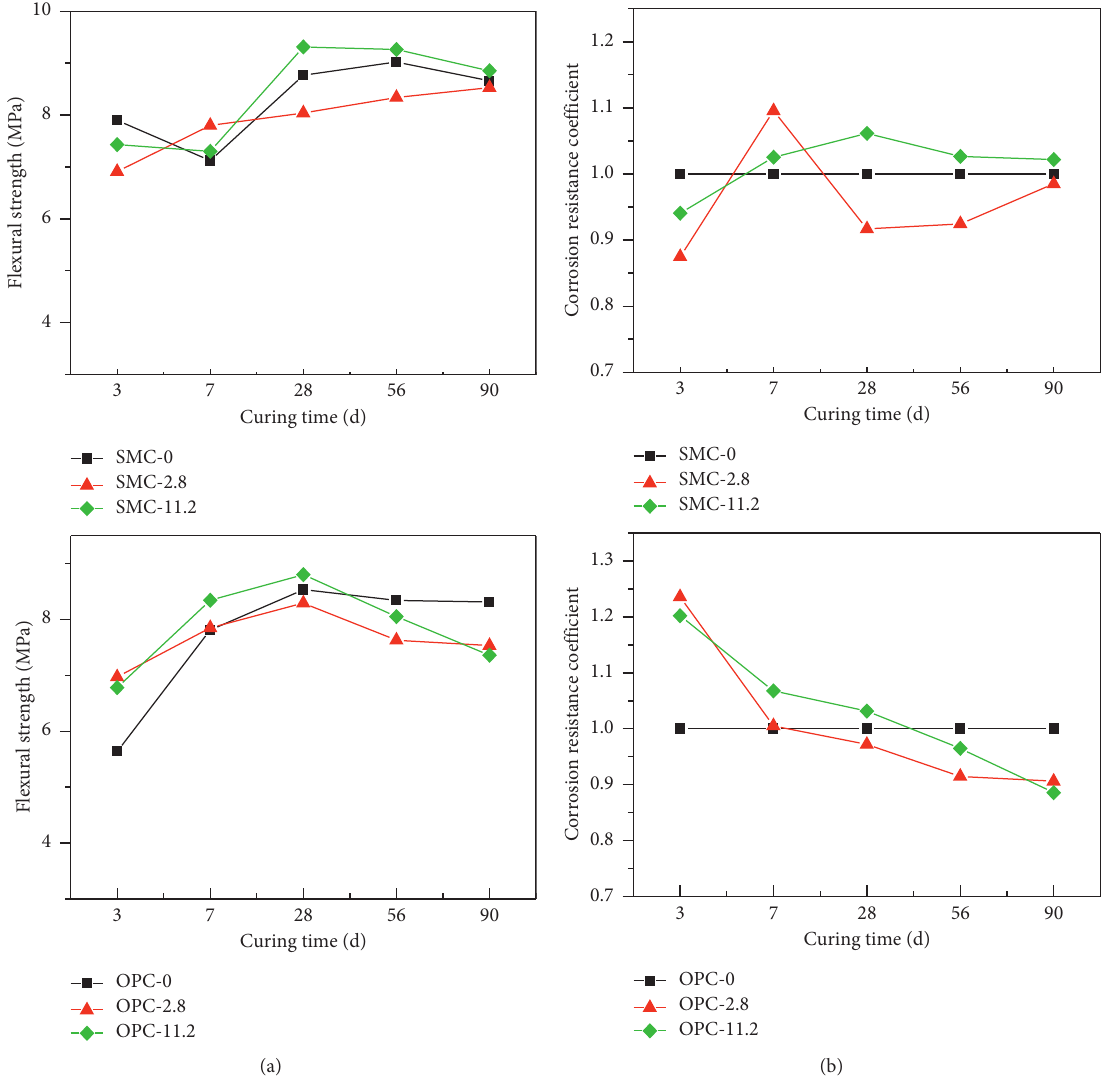
Figure 3: Mechanical properties of leaching specimens at different ages and flow rates: (a) flexural strength; (b) leaching resistance